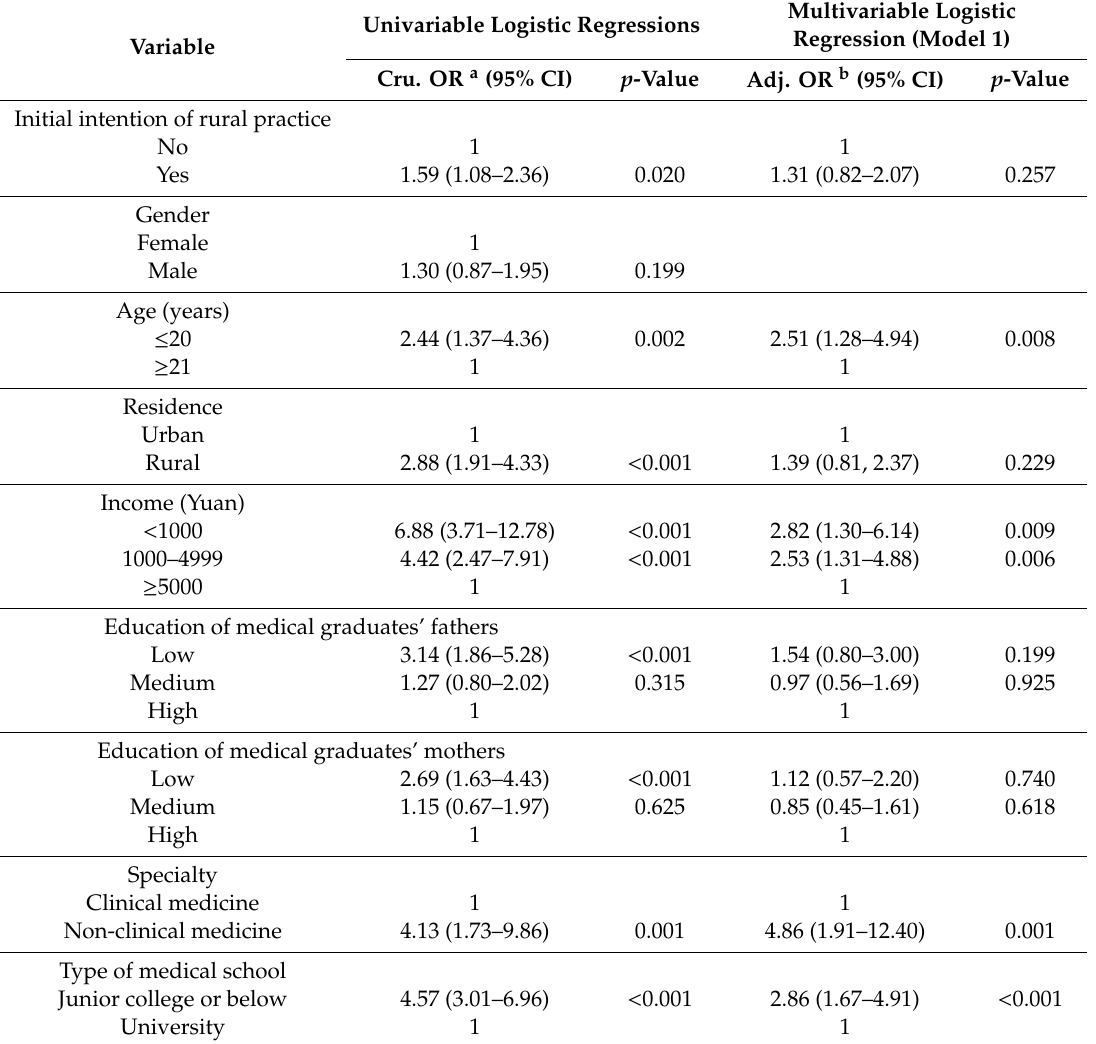
a Cru. OR: crude odds ratio. b Adj. OR: adjusted odds